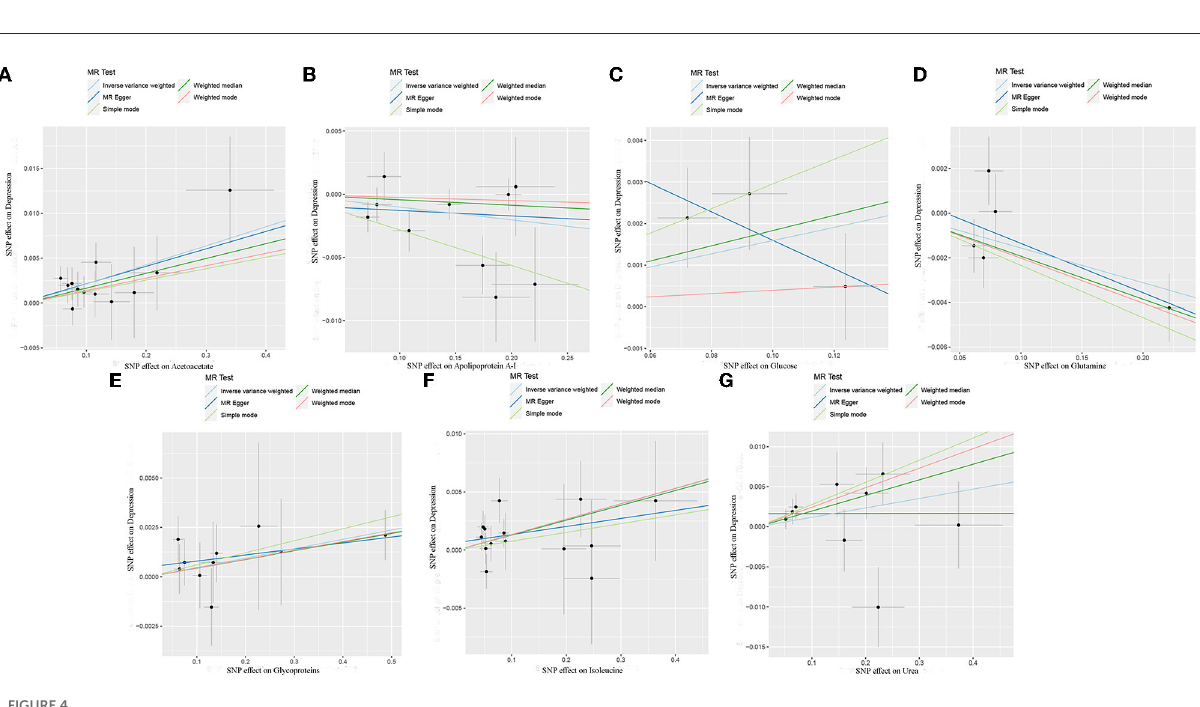
which further showed that the causal effect was not biased by pleiotropy. In addition, no heterogeneity was observed in our study (acetoacetate, P = 0.871, I 2 = 0.000%; apolipoprotein A-I, P = 0.135, I 2 = 34.134%; glucose, P = 0.240, I 2 = 29.955%; glutamine, P = 0.244, I 2 = 26.614 %; glycoproteins, P = 0.944, I 2 = 0.000%; isoleucine, P = 0.697, I 2 = 0.000%; urea, P = 0.175, I 2 = 30.467%; Table